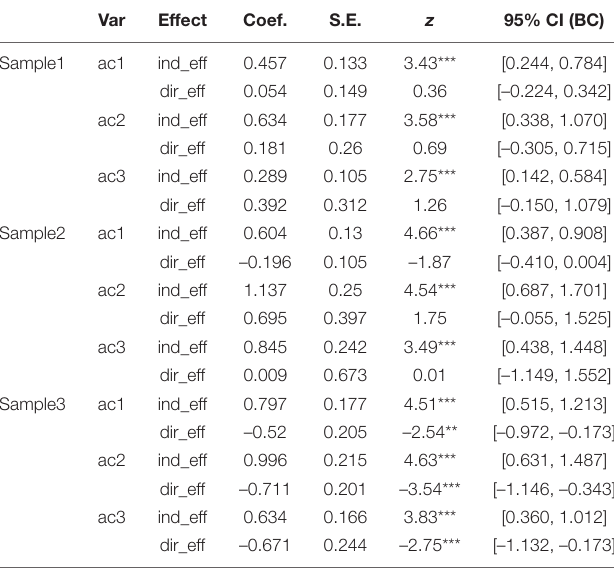
TABLE 2 | Results of